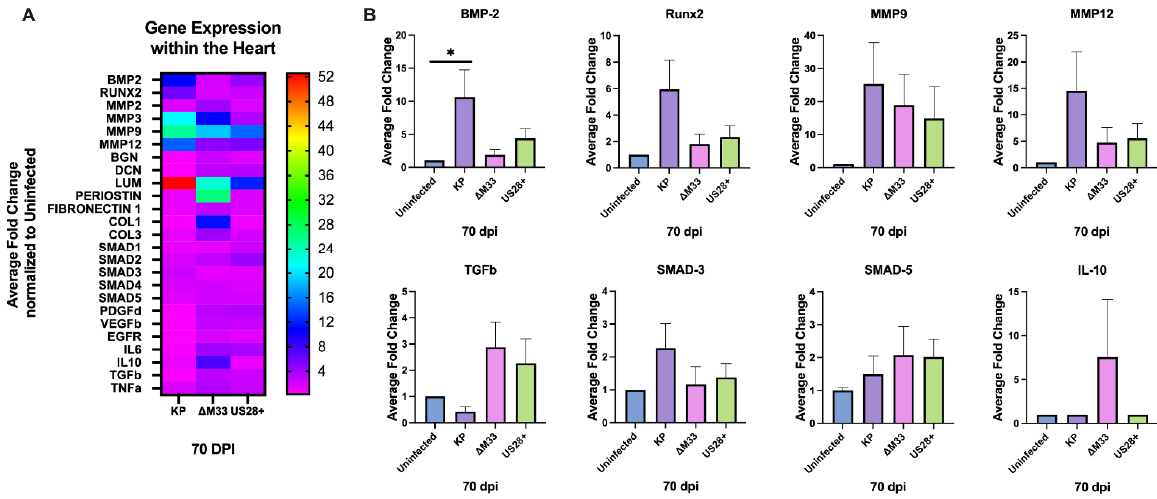
Figure 7. MCMV-induced upregulated gene expression at 70 dpi. Animals were uninfected or infected with 1 × 10 6 PFU MCMV by i.p. inoculation. At 70 dpi, RNA was extracted from 0.1 g of tissue. Additionally, 100 ng of cDNA was synthesized per sample, and qPCR was conducted with a panel of cellular genes. Results are presented as ( A ) a heat map with color coding based on induced upregulated fold change or ( B ) a bar graph with the average fold change per group normalized to the uninfected samples. Two-log fold change was determined by using the cellular housekeeping gene GAPDH. Significance was determined by ANOVA and Tukey’s multiple comparisons test. * p < 0.05. This study was conducted once ( n = 5).